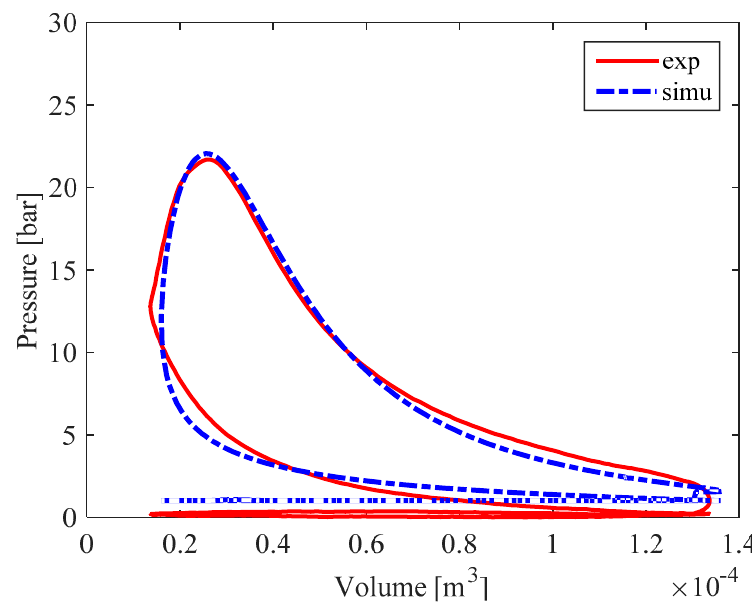
Figure 8. In-cylinder pressure vs. volume for the experiments (solid red line) and simulations (dash blue line).